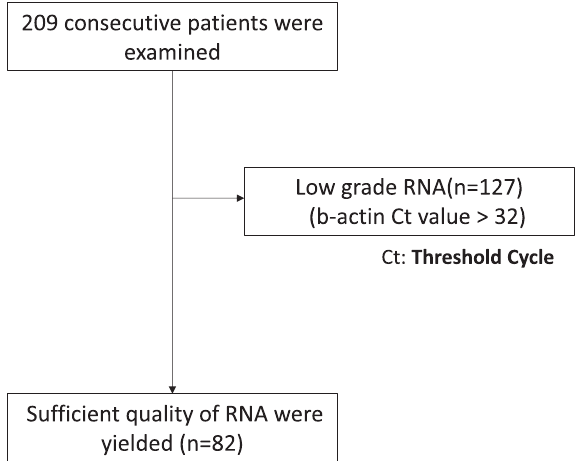
Figure 1. Diagram of patient